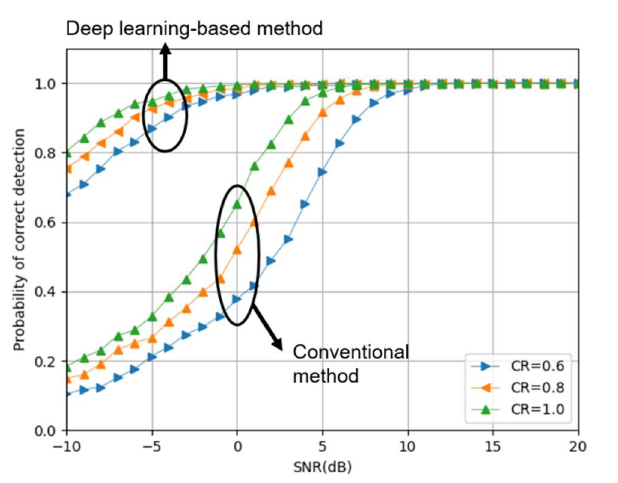
Figure 8. Frame format detection accuracy of deep-learning-based and conventional methods according to three clipping ratio (CR) values.